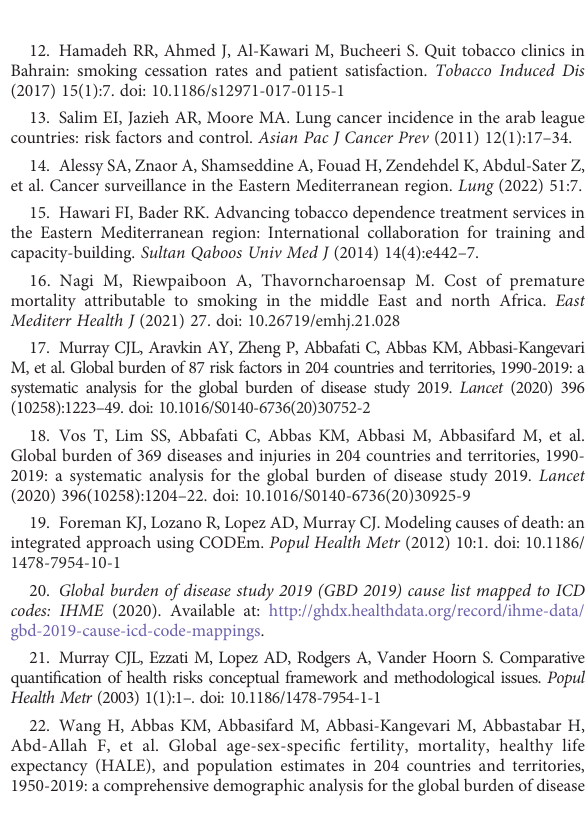
SUPPLEMENTARY TABLE 1 Data used for TBL cancer in the NAME region. SUPPLEMENTARY TABLE 2 Decomposition analysis of new cases change cause by sex in countries of the region, between 1990 and 2019. SUPPLEMENTARY TABLE 3 Age-standardized rate (per 100,000) of incidence, prevalence, deaths, DALYs, YLDs, and YLLs in counties of the region by sex in 1990 and 2019 with their percent changes YLLs, years of life lost; YLDs, years lived with disability; DALYs, disability-adjusted life years. SUPPLEMENTARY TABLE 4 Attributed age-standardized rate (per 100,000) of deaths, DALYs, YLDs, and YLLs to all risk factors in countries of the region by sex in 1990 and 2019 with their percent changes YLLs, years of life lost; YLDs, years lived with disability; DALYs, disability-adjusted life years. SUPPLEMENTARY FIGURE The ranking of age-standardized attributed burden to risk factors at the NAME region and its countries, 2019 (A) deaths, (B)